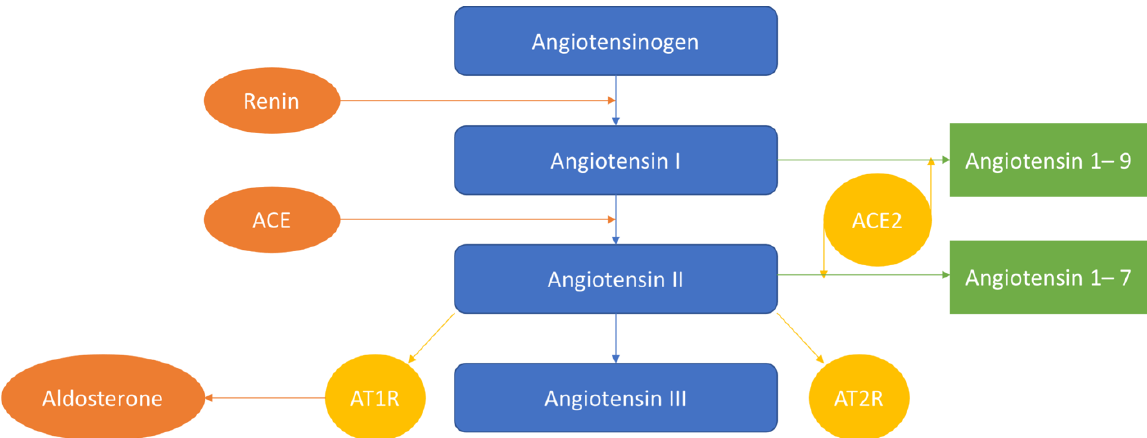
Figure 1. Renin cleaves angiotensinogen into 10 peptides (Angiotensin I). With the help of the angiotensin-converting enzyme (ACE), Angiotensin-I can be further cleaved to Angiotensin-II. Then, Angiotensin-I is converted to Angiotensin-1–9, and Angiotensin-II—to Angiotensin-1–7 by ACE2. Then, Angiotensin-II is converted into Angiotensin-III. Angiotensin-II acts on Angiotensin II receptor 1 (AT1R) and AT2R.